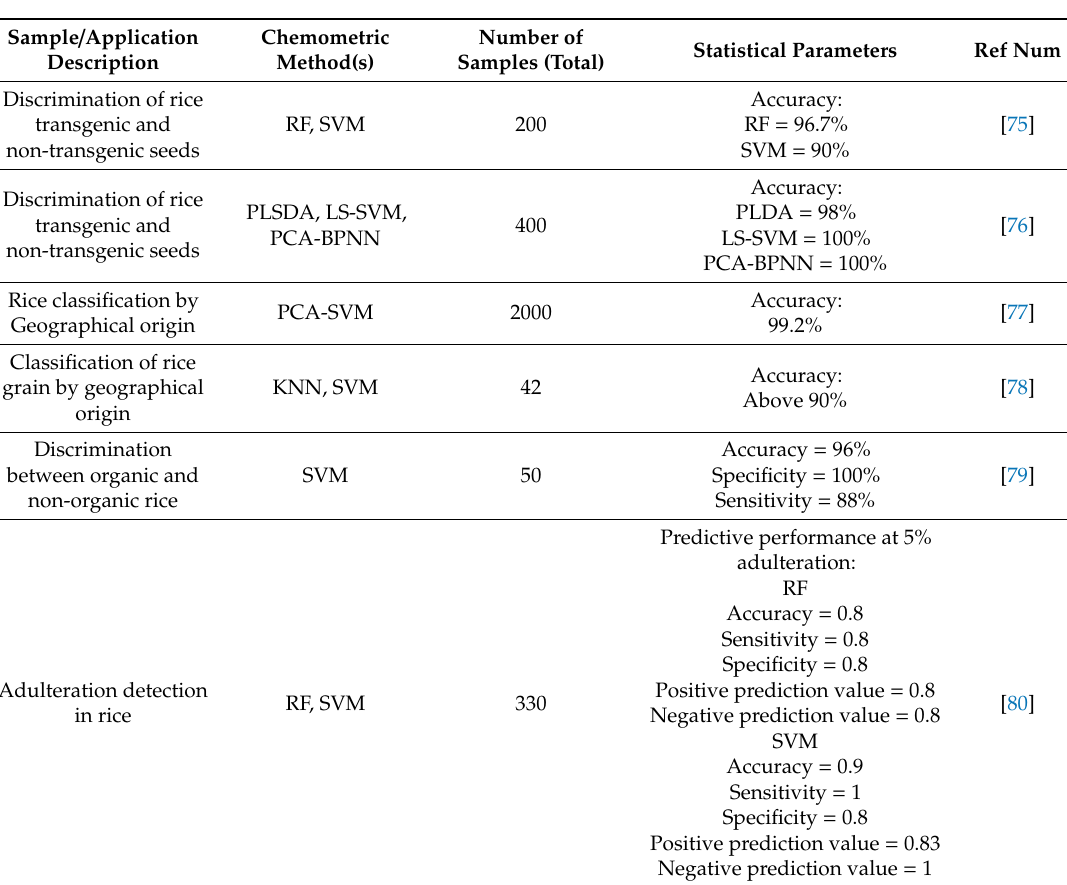
Table 3. Literature related to the use of chemometrics in classification of